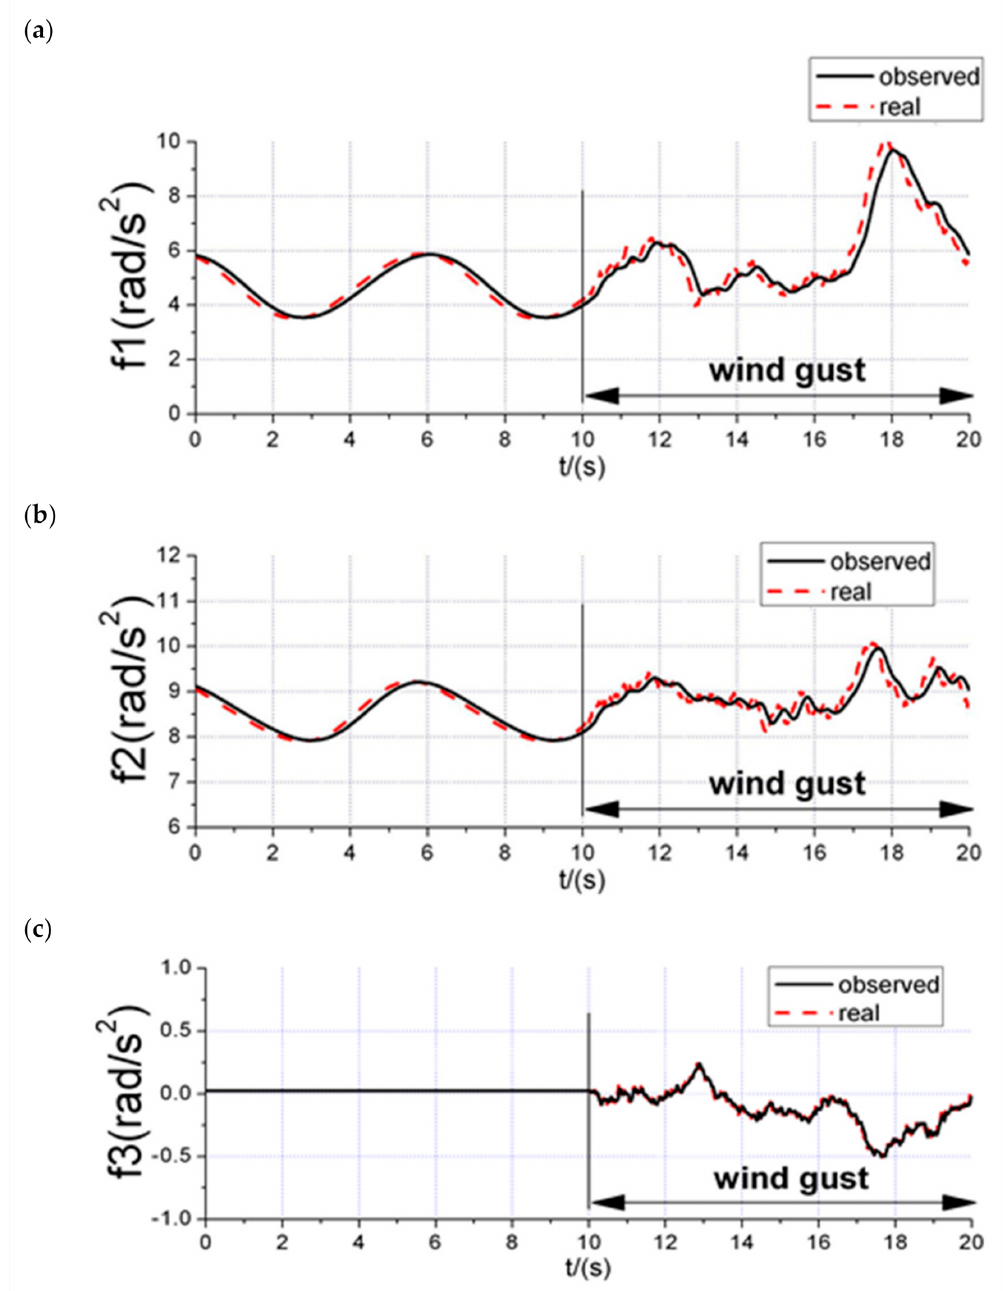
Figure 3. Disturbances observation without uncertainties. ( a ) Estimation of f1; ( b ) estimation of f2; ( c ) estimation of